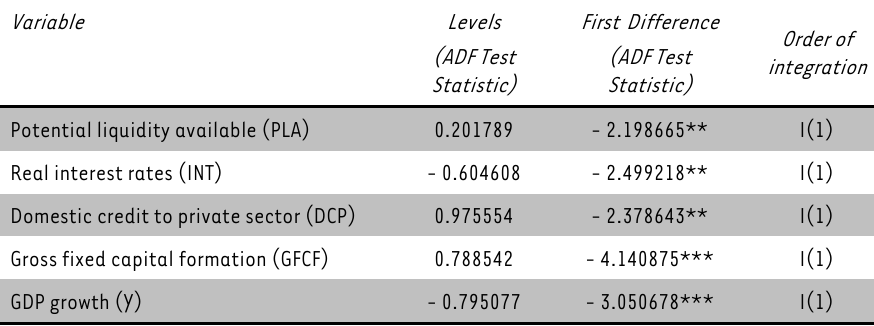
TABLE 1: ADF unit root test results for stationarity of variables Variable